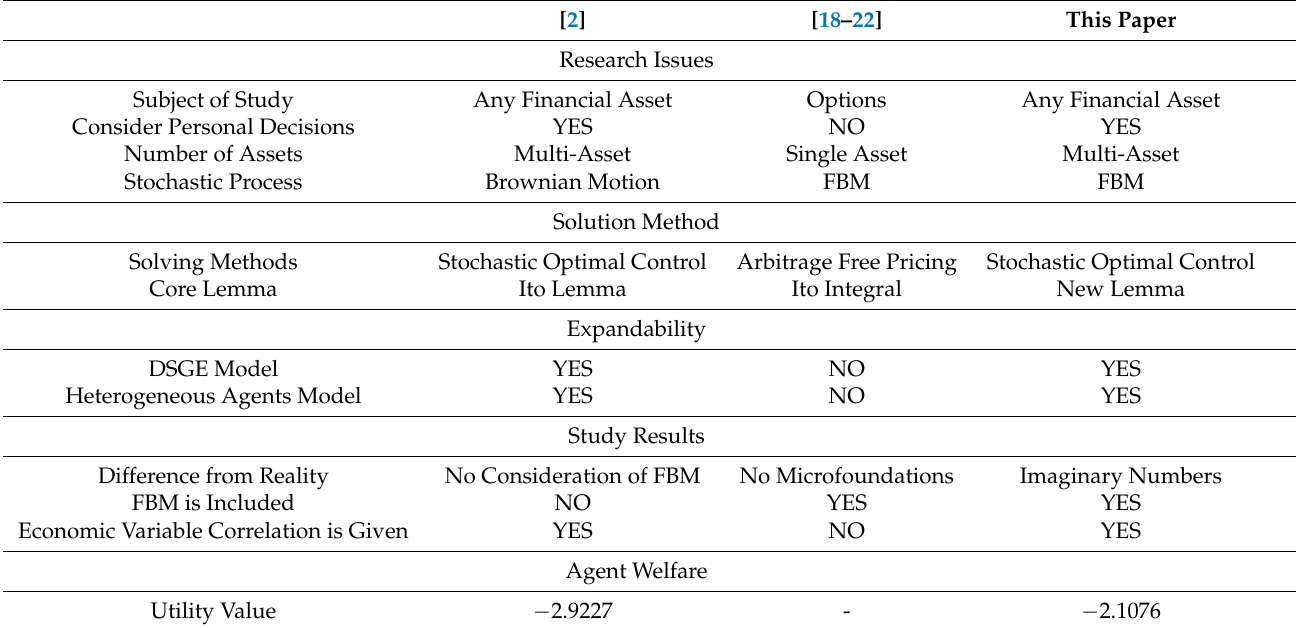
Table 3. Comparison of Results and Numerical